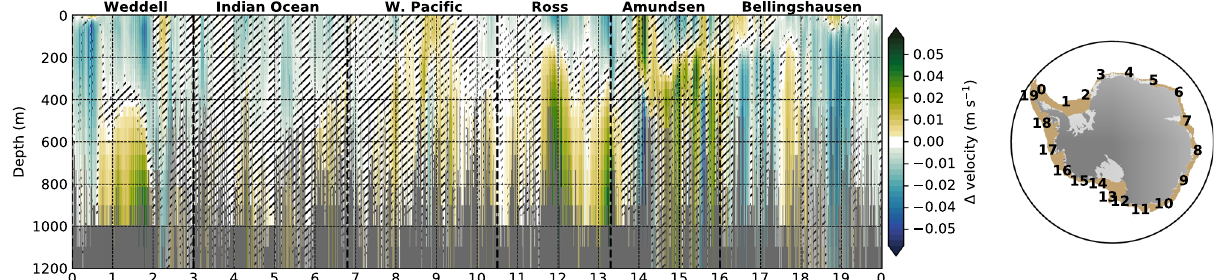
Fig. 7 Slope current velocity change due to a positive SAM perturbation. Vertical section of the geostrophic slope current velocity (de fi ned as the along- slope geostrophic velocity at the continental shelf break 85 ) change between the SAM + run and the CTRL run, averaged over years 25 to 29. The bedrock bathymetry is represented in gray. Hatching indicates non-signi fi cant changes at the 95% level. The x-axis represents the position along the shelf break, indicated by numbers from 0 to 19 located on the inset map (the continental shelf is represented in tan).